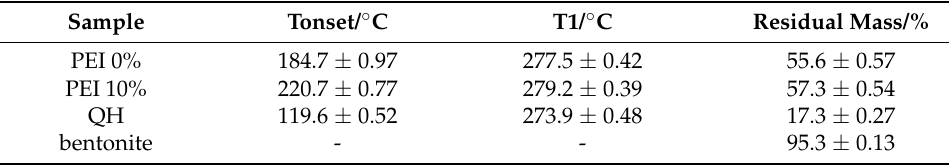
Figure 6. TGA curves of QH, bentonite, PEI 0% and PEI 10% ( A , C ), the DTA curves of QH ( B ), the DTA curves of PEI 0% ( D ), the DTA curves of PEI 10% ( E ). Table 2. TGA and DTG data of composite films, bentonite, and QH.